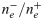
AUPR as a function of the ne-/ne+ ratio for increasing numbers random extra-task points in the train set.(a): NN-MT. (b): RN-MT. The blue horizontal line corresponds to MT-intra (which is trained only on intra-task pairs). Numerical values can be found in Supporting Information S5 and S6 Tables.